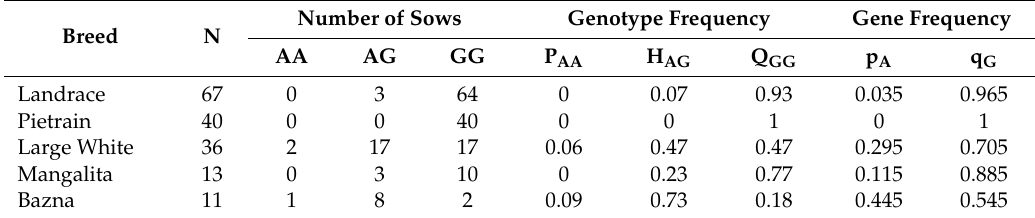
Table 1. CSN2 c.647G>A polymorphism: Genotype and gene frequencies in different breeds. Number of Sows Breed N Breed